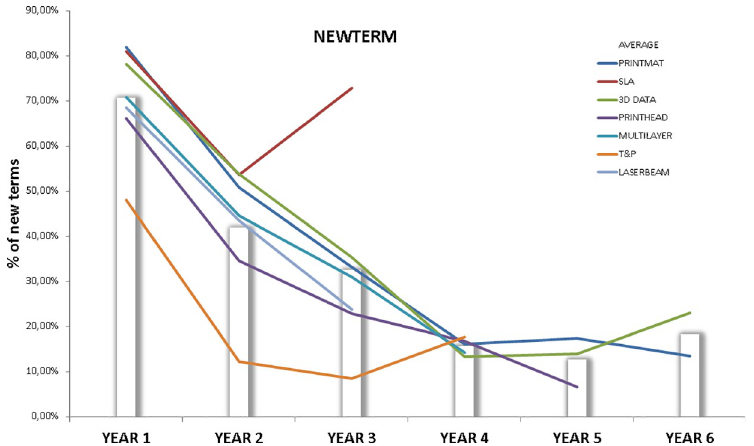
Fig 17. NEWTERM for each technology front. This figure shows the evolution of NEWTERM indicator for each technology front. Data points above the bars indicate higher than average presence of new and relevant terms.